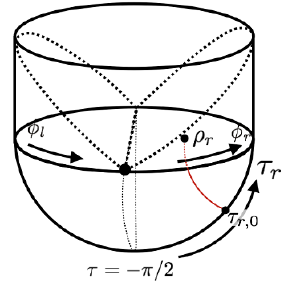
Figure 3 . We can construct the map between bulk points and boundary points. This map can be obtained by the geodesics just the same as the global